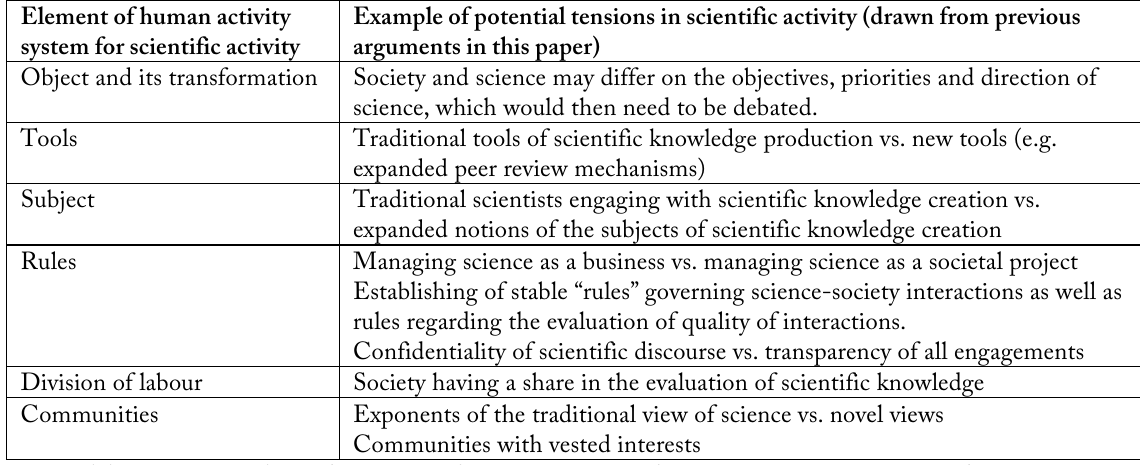
Table 3: Examples of potential tensions in a human activity system for science- society